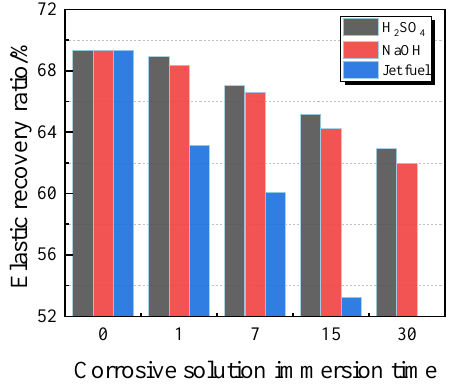
Figure 12. Elastic recovery ratio of PCFC under different corrosion solution immersion time.